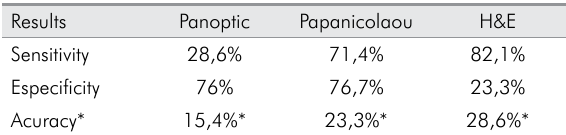
Table 2. Comparision of the three stains techniques ac- cording to sensitivity, specificity and